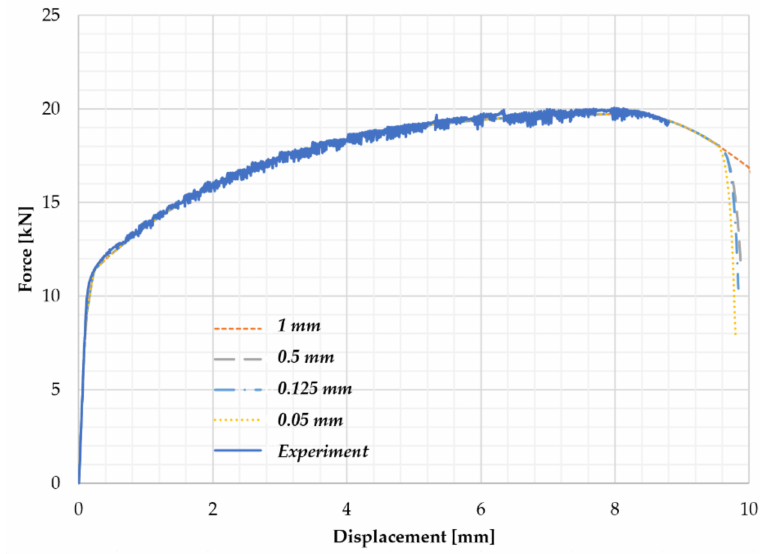
Figure 9. Effect of the mesh size on the force–displacement response.